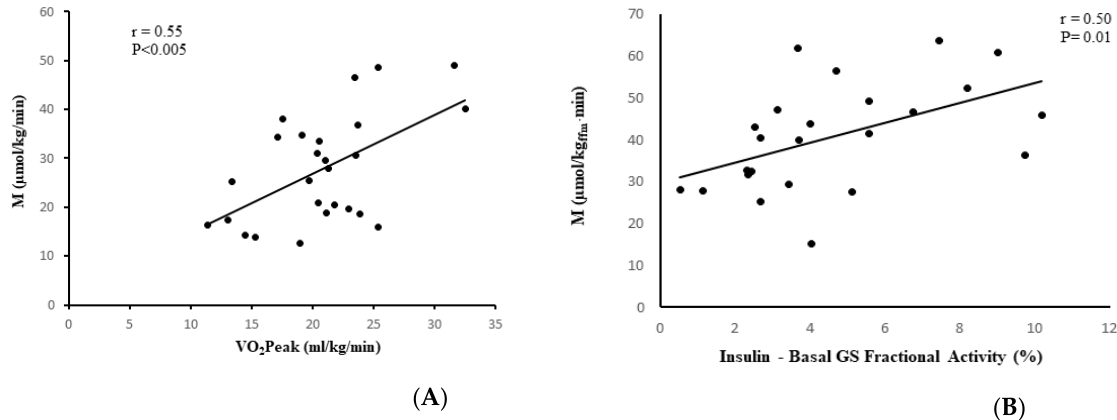
Figure 4. Correlation analysis with fitness and GS. ( A ) Relationship between VO 2 peak and glucose utilization (M) in stroke participants ( n = 26; r = 0.55, p < 0.005). ( B ) Relationship between glucose utilization (M) and absolute change in GS fractional activity in paretic muscle in stroke participants ( n = 24; r = 0.50, p = 0.01).